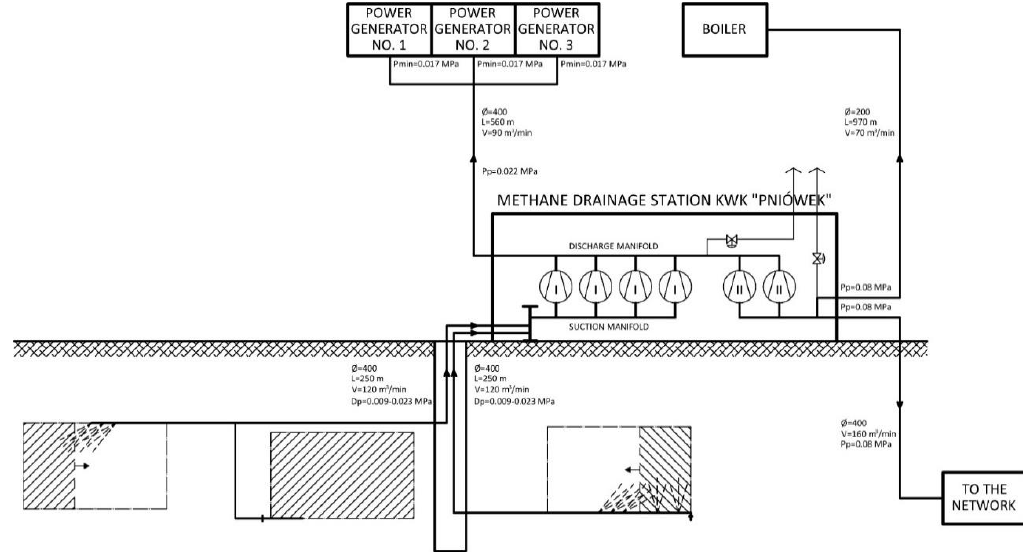
Figure 5. Methane drainage system installation located in the Pniówek coal mine.